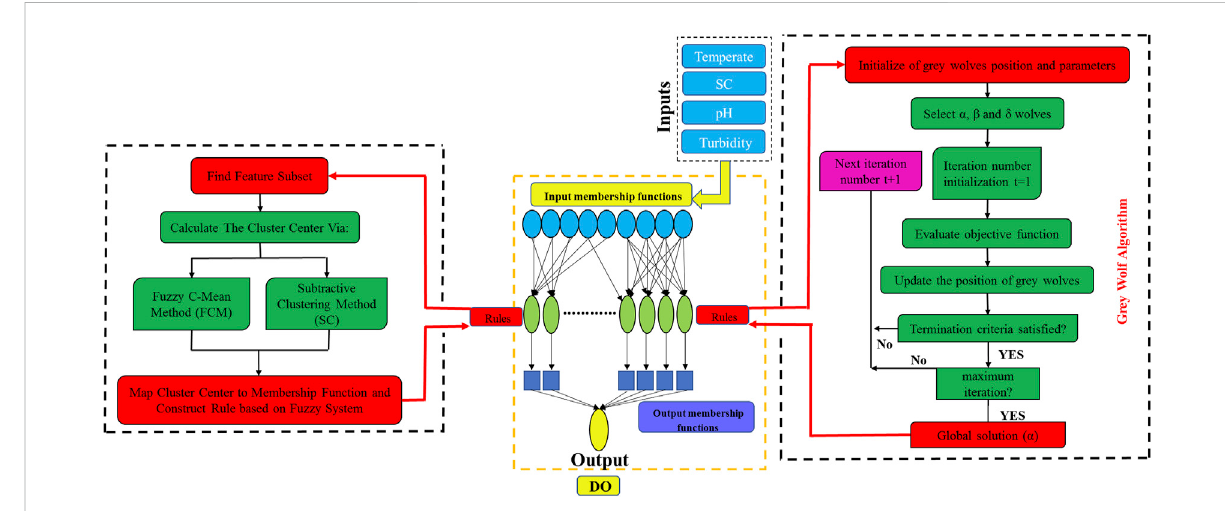
FIGURE 3 Flowchart of applied